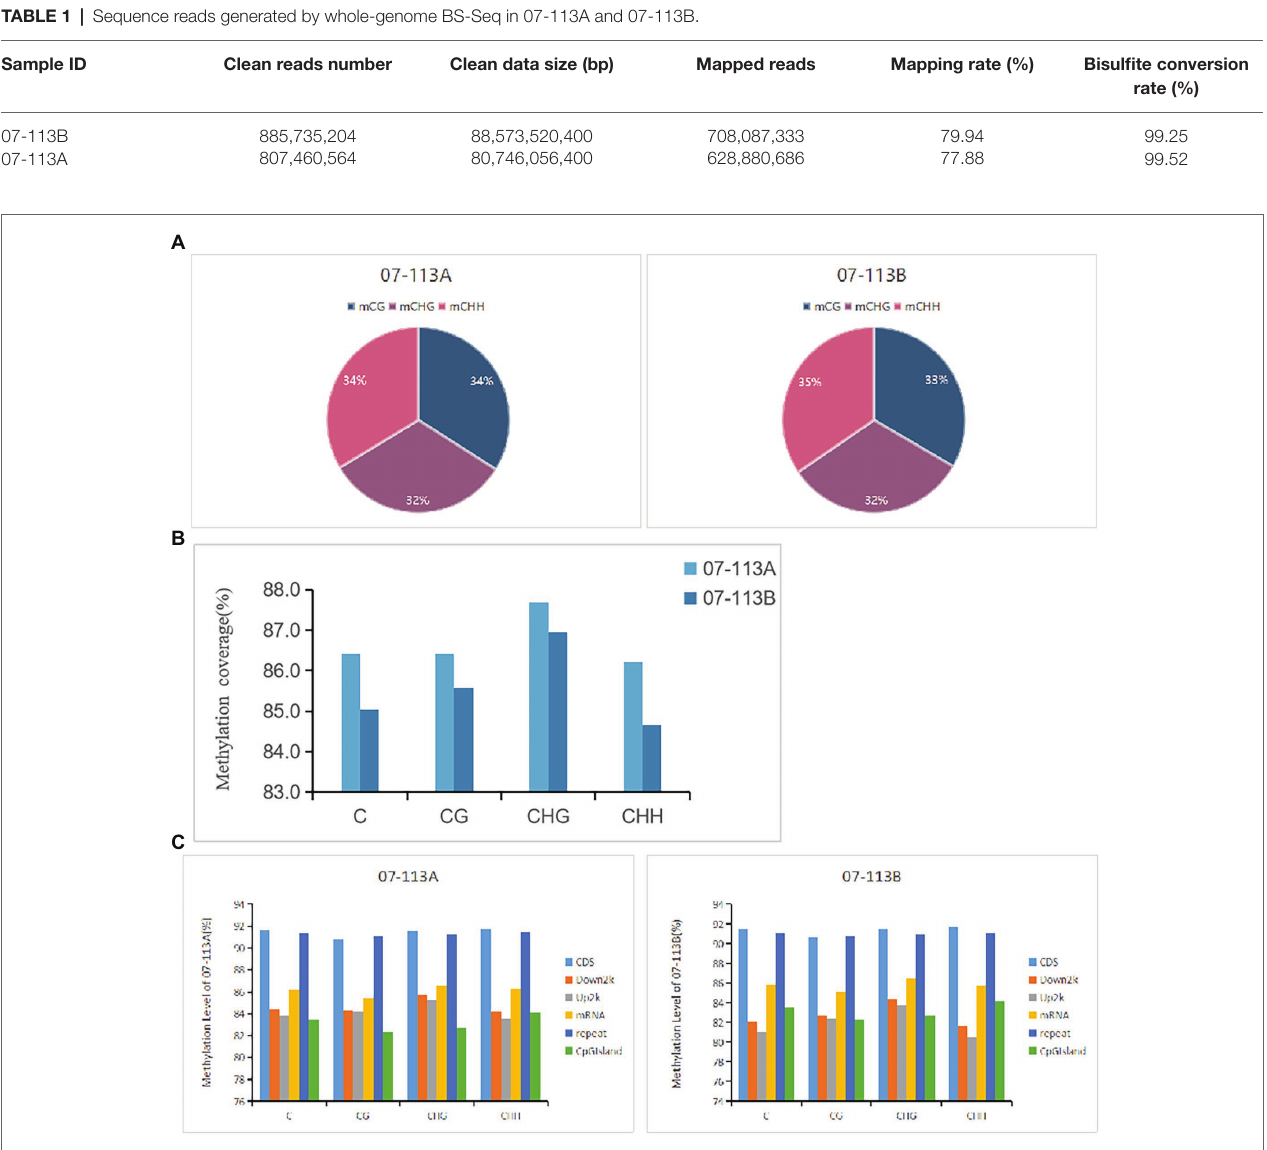
FIGURE 2 | Comparative analysis of DNA methylation patterns between 07-113A and 07-113B. (A) Distribution of methylated cytosines in the three contexts of 07-113A and 07-113. (B) Methylation coverage in each sequence context across the whole cotton genome. (C) The coverage of methylation level in various genomic regions.